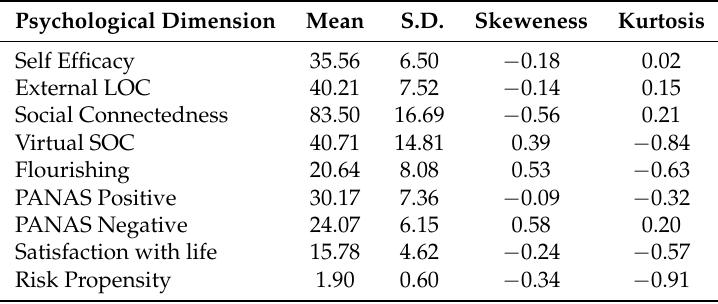
Table A1. Descriptive statistics for psychological dimensions of the